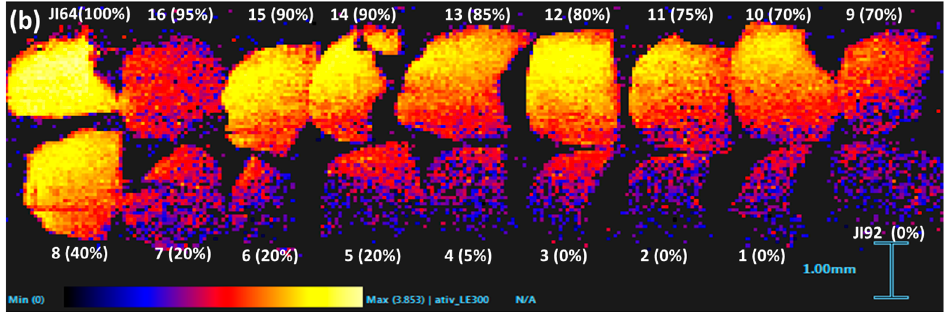
Figure 5. Relationship of HLFA signals to the dormancy level of JI64, JI92 and respective recombinant inbred lines. ( a ) signals of individual hydroxylated long chain fatty acids in parent genotypes and RILs obtained by LDI-MS measurement, black bars denote non-dormant and gray ones dormant lines; signal is expressed as an average of normalized intensities of four repeated measurements; ( b ) distribution of dihydroxyoctacosanoate on the RILs’ surface; numbers at x-axis denote particular RIL lines (1–16), numbers given above the codes of lines in graphs or in parenthesis in mass images, respectively, reflect the dormancy level in percents.